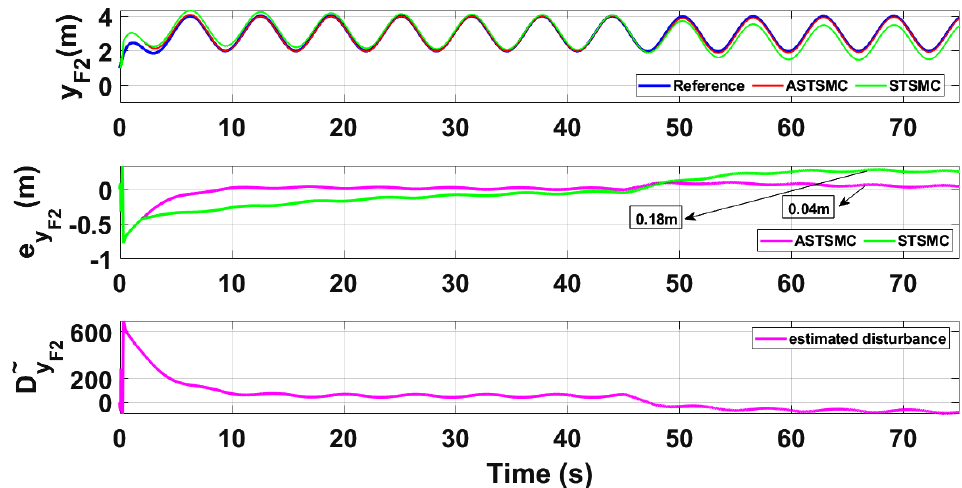
Figure 14. Y F 2 tracking comparison under wind disturbance.